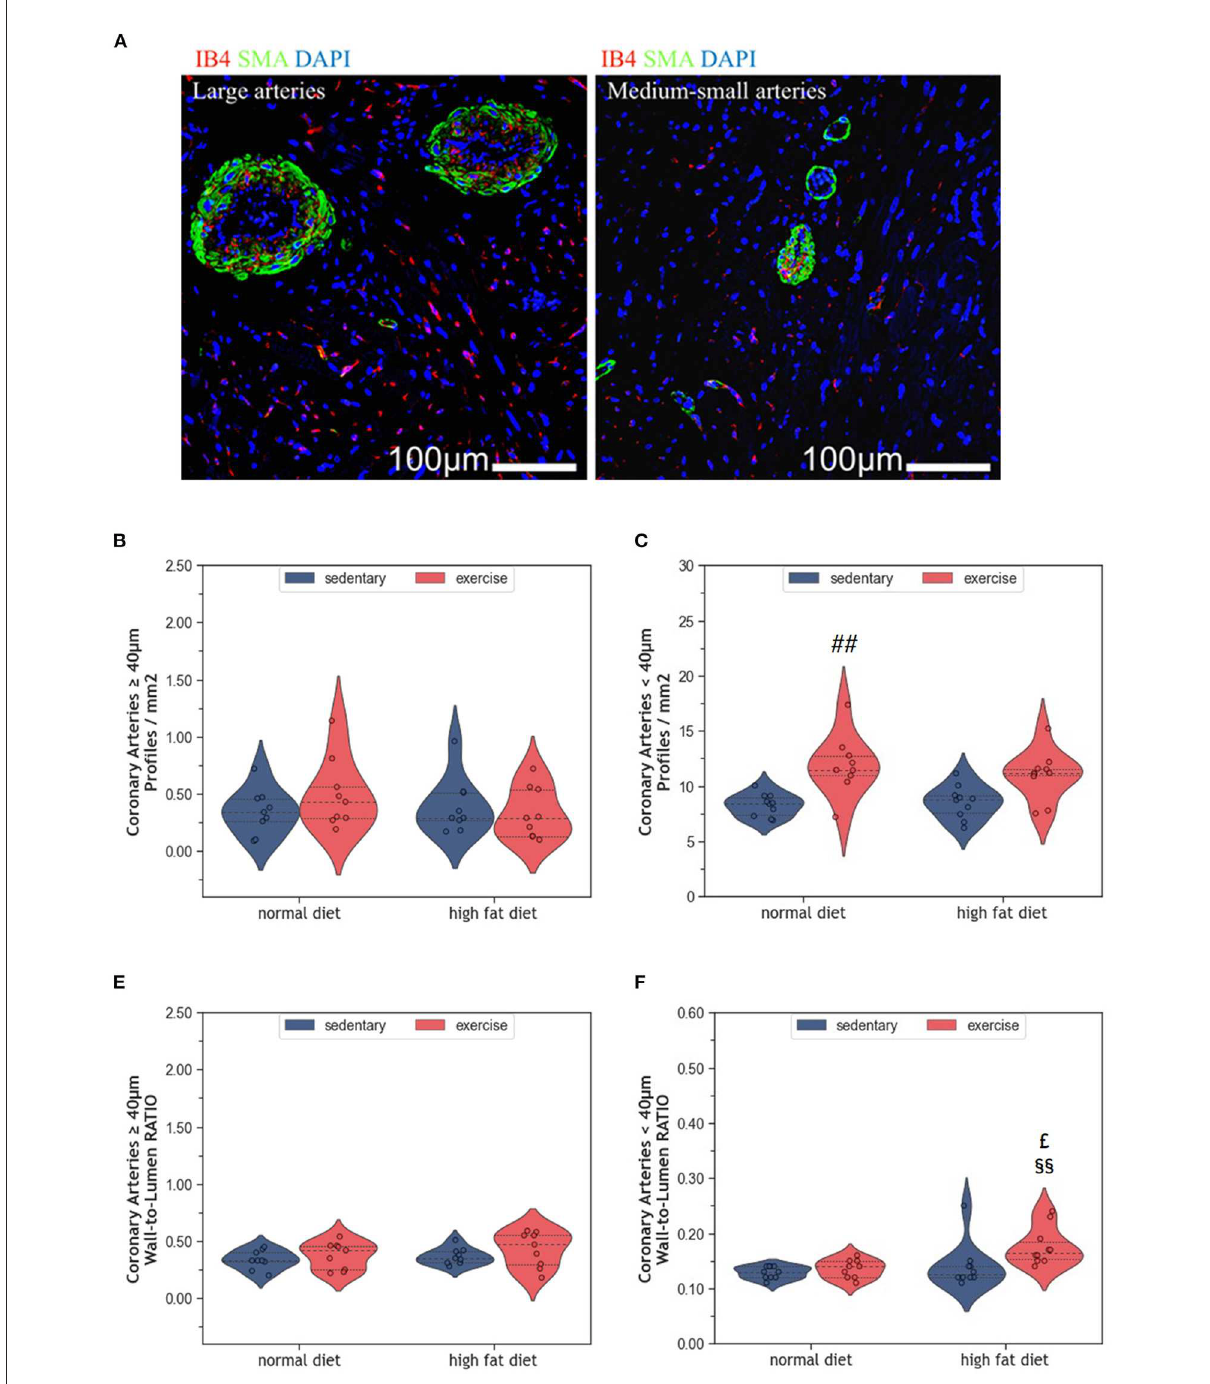
FIGURE6 (A) Representative histological images of left ventricular myocardium showing coronary arteries of large and medium-small caliber. The sections were co-immunostained with ILEB4, anti-SMA antibody, and DAPI. (B) Violin plot showing the total number of large coronary arteries of left ventricular cardiomyocytes. (C) Violin plot showing the total number of medium-small coronary arteries of left ventricular cardiomyocytes. (D) Violin plot showing the wall-to-lumen ratio of large arteries. (E) Violin plot showing the wall-to-lumen ration of medium-small arteries. From each experimental group 10 animals were selected for histomorphometry analysis. Statistical differences between groups were calculated with the Kruskal-Wallis test adjusted by the Bonferroni correction for multiple tests. p -values are only shown for pre-specified group comparisons. ## p < 0.01 compared to the sedentary normal diet group; £ p = 0.039 compared to the exercise normal diet group; §§ p = 0.007 compared to the sedentary high fat diet